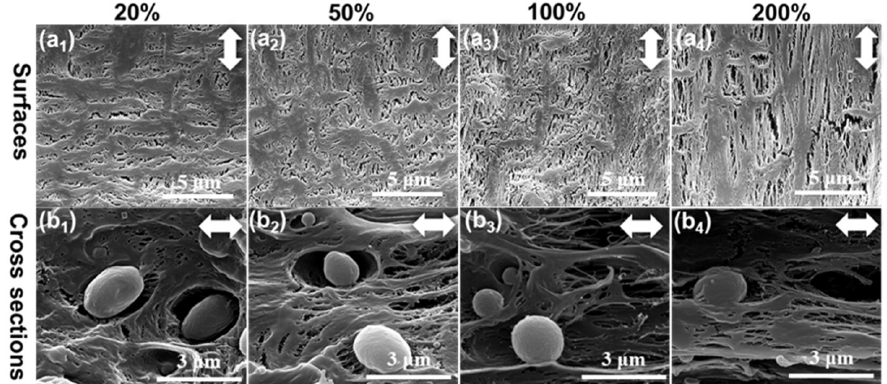
Figure 5. SEM images of the ( a1 – a4 ) surface and ( b1 – b4 ) cross-section microporous structure of PA6/PP(S) films during longitudinal stretching. The tensile temperature was 100 °C and the tensile strains were ( a1 , b1 ) 20%, ( a2 , b2 ) 50%, ( a3 , b3 ) 100%, and ( a4 , b4 ) 200%. The white double arrow represents the direction of stretching.